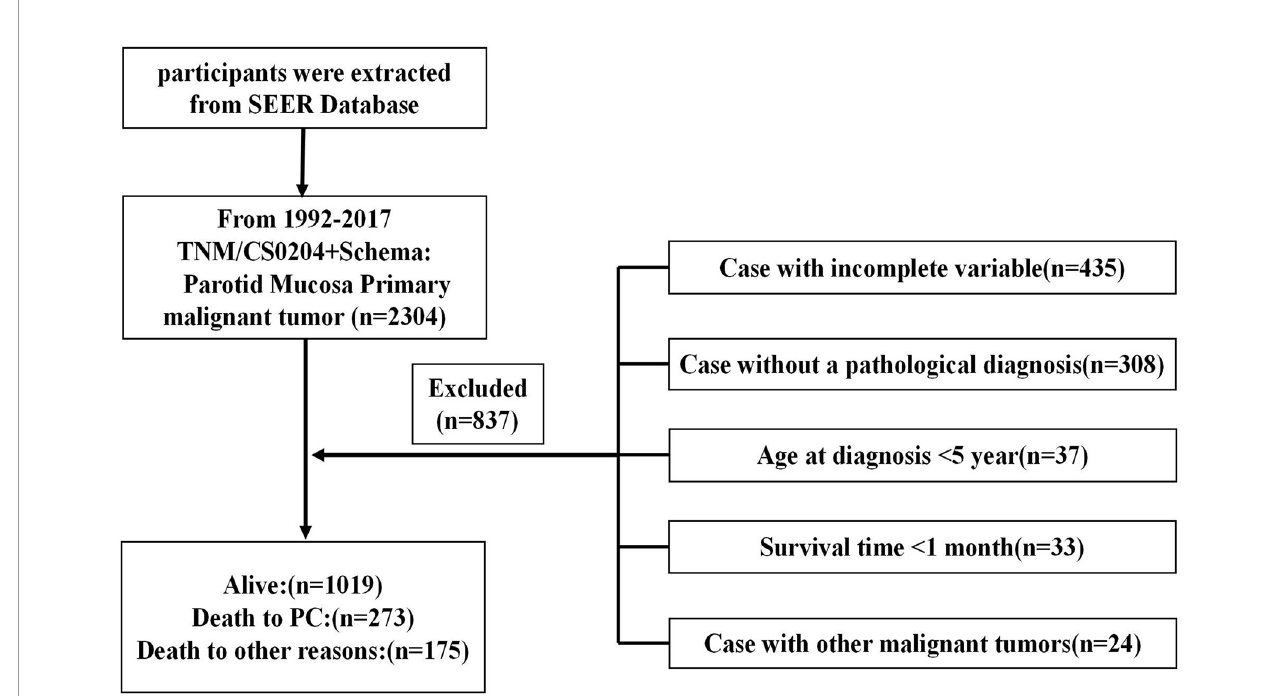
FIGURE 1 | Flow diagram illustrating recruitment of patients. SEER, Surveillance, Epidemiology, and End Results; PC, parotid